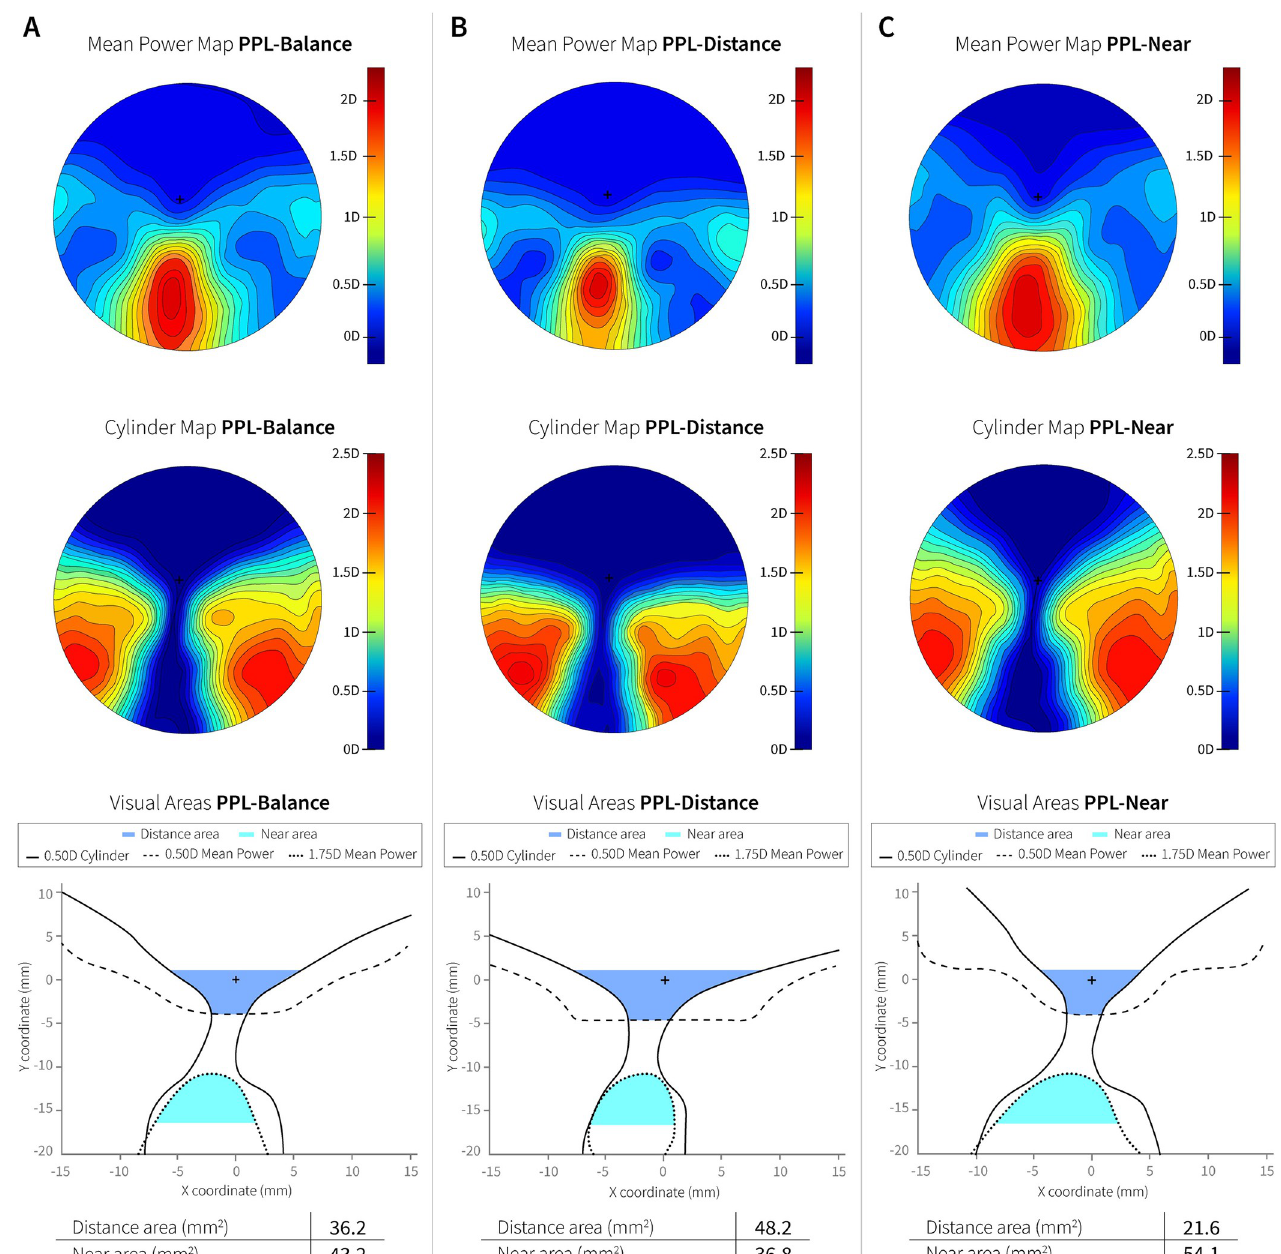
Fig 1. Mean power, cylinder power maps distribution, and visual areas according to Sheedy’s criteria for plano addition 2.00D prescription using standard parameters of the PPLs tested in the research. A) PPL-Balance. B) PPL-Distance. C) PPL-Near. https://doi.org/10.1371/journal.pone.0281861.g001 Lenses were calculated using fitting parameters and position of wear of the ET with the clip-on using advanced optical design software (Freeform designer, IOT, Madrid, Spain) to reduce oblique aberrations and maintain fields of view stable independent of each subject’s prescription and/or addition power for all gaze directions. According to Sheddy’s criteria [28], the PPL-Distance lens has a 29% wider field of view and the PPL-Near lens a 22% narrower field of view in the distance zone compared to the control lens (PPL-Balance). In the near